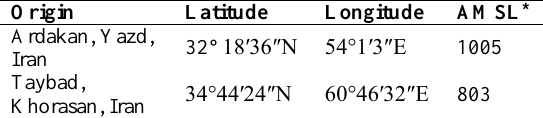
Table 1. Geographical coordinates of studied